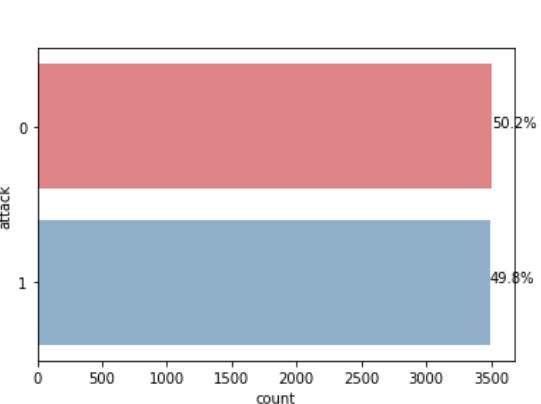
Figure 2. Relation between count and